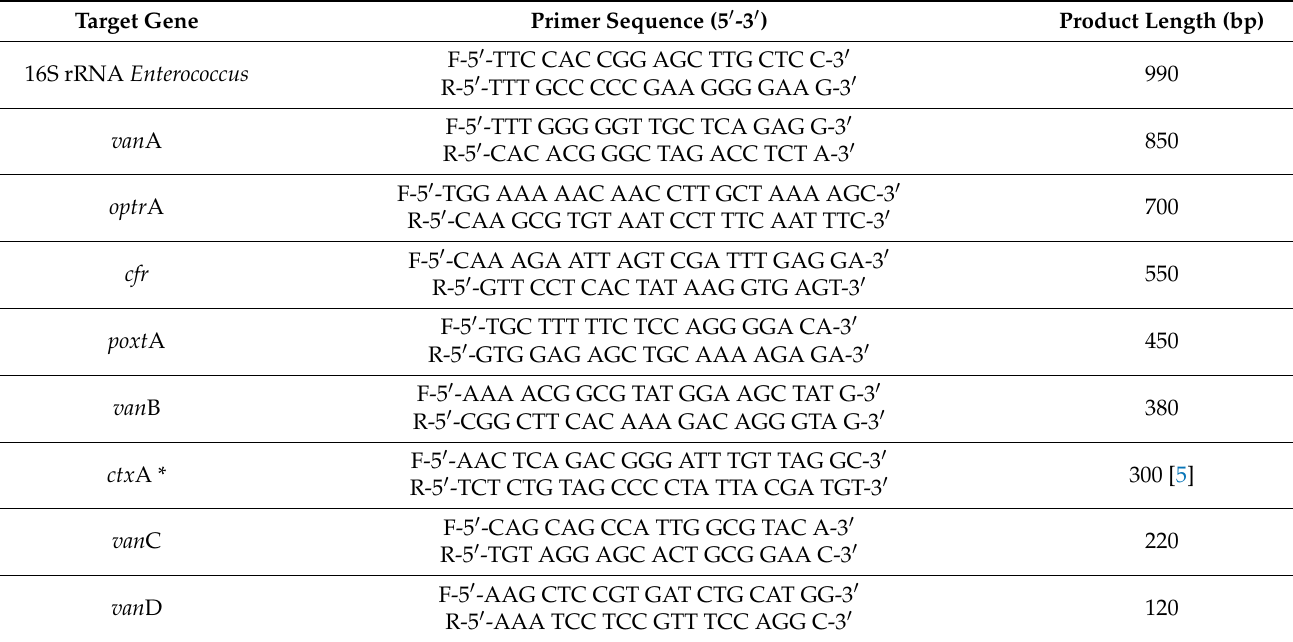
Table 4. Characteristics of the primers used in this